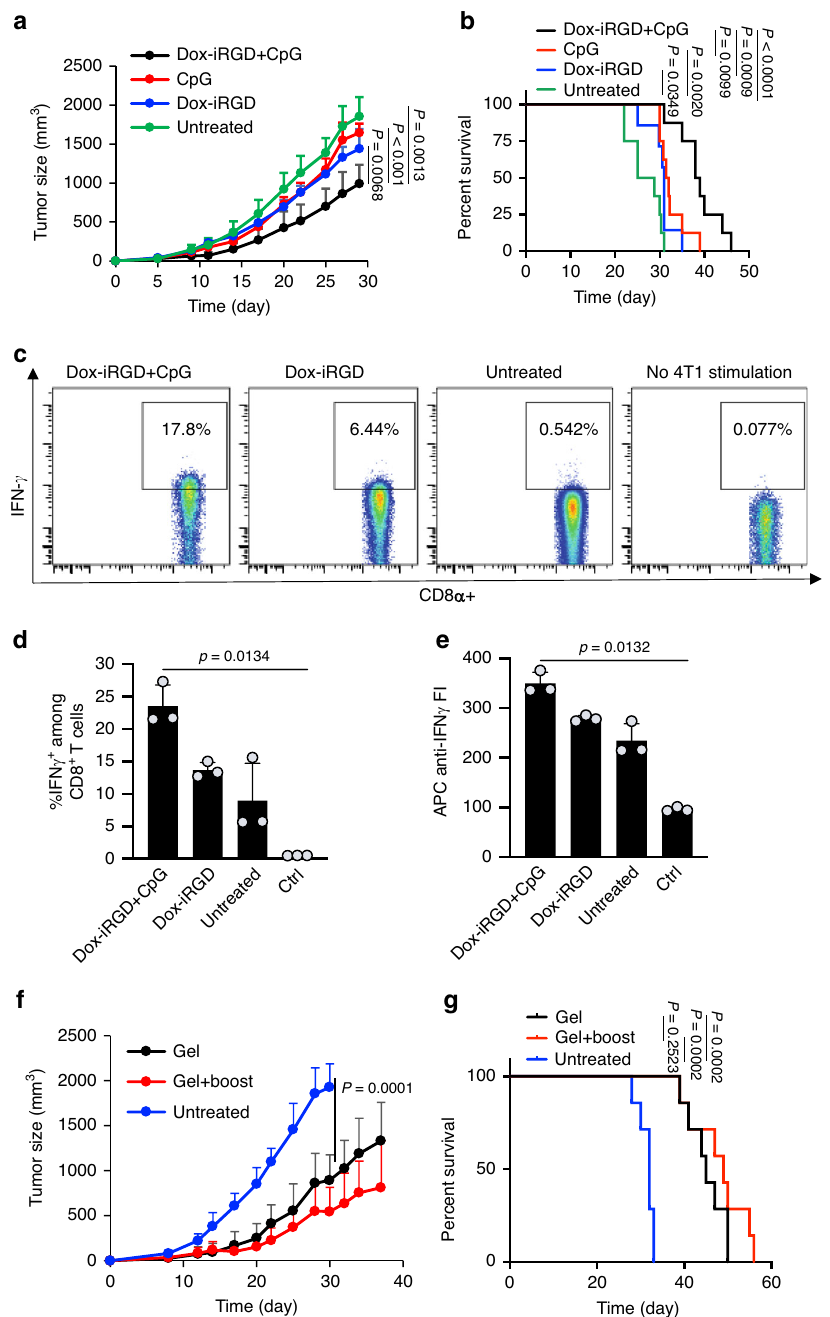
Fig. 4 Pore-forming gels loaded with GM-CSF, Dox-iRGD, and CpG improve tumor-speci fi c CTL responses and antitumor ef fi cacy against 4T1 triple- negative breast cancer. a , b 4T1 cells were injected subcutaneously on day 0. Mice were untreated or treated with gels containing Dox-iRGD (100 μ g) and CpG (50 μ g) or Dox-iRGD (100 μ g) alone or CpG (50 μ g) alone on day 5. GM-CSF was incorporated in all groups. a Average 4T1 tumor volume of